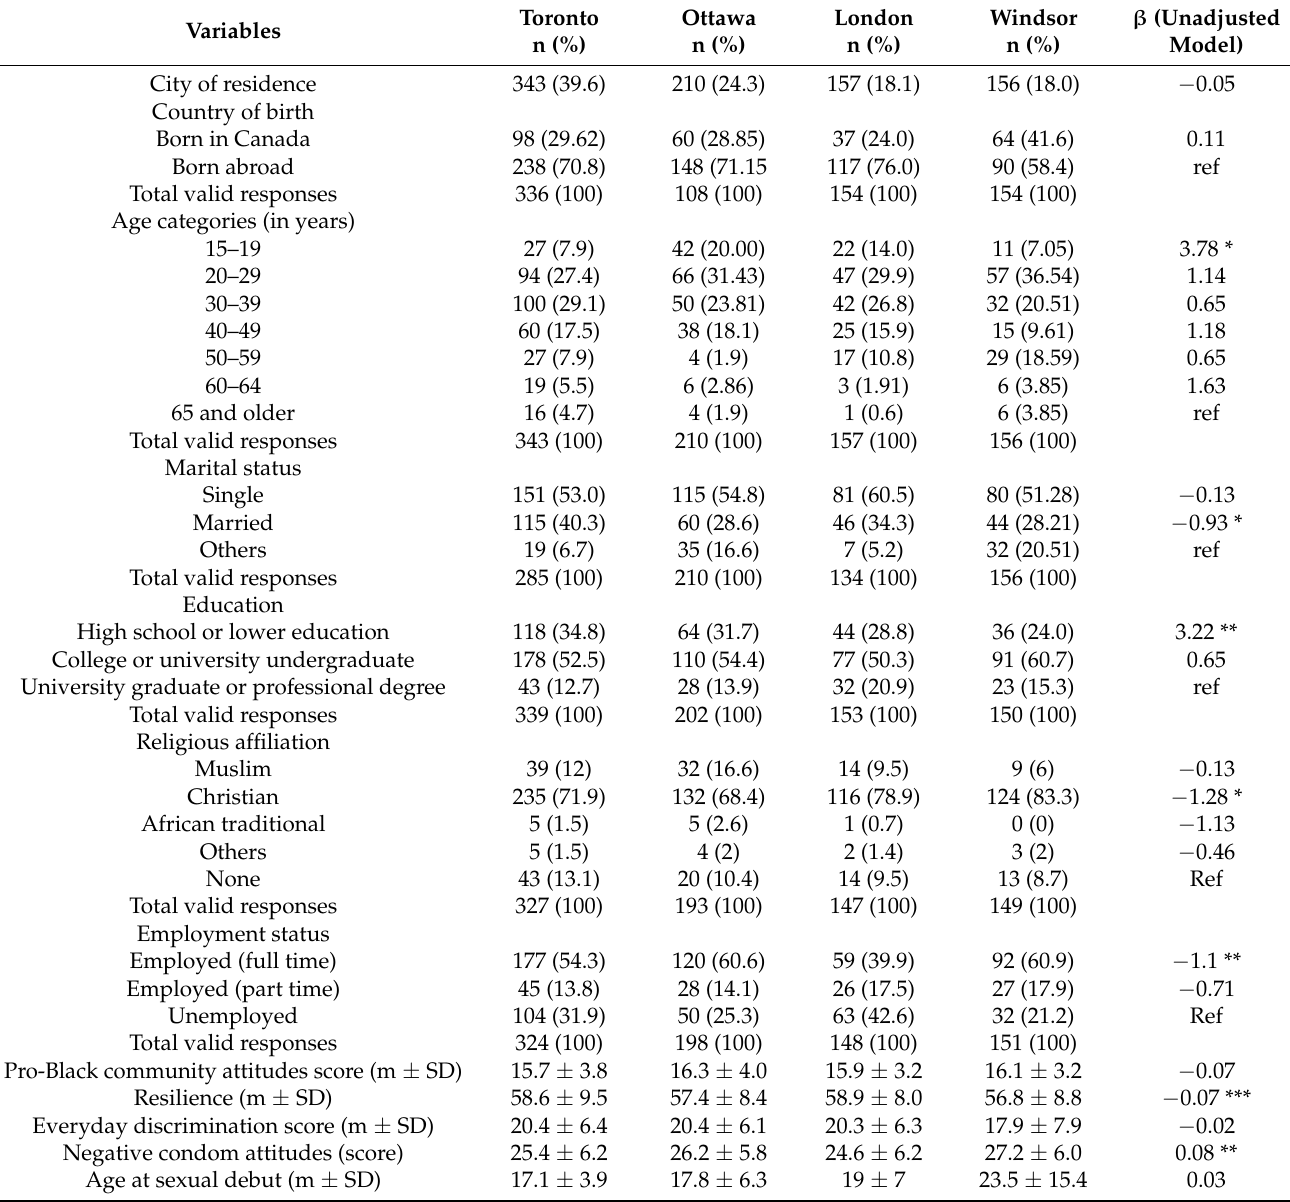
Table 1. Descriptive analysis of independent variables: socioeconomic and psychosocial